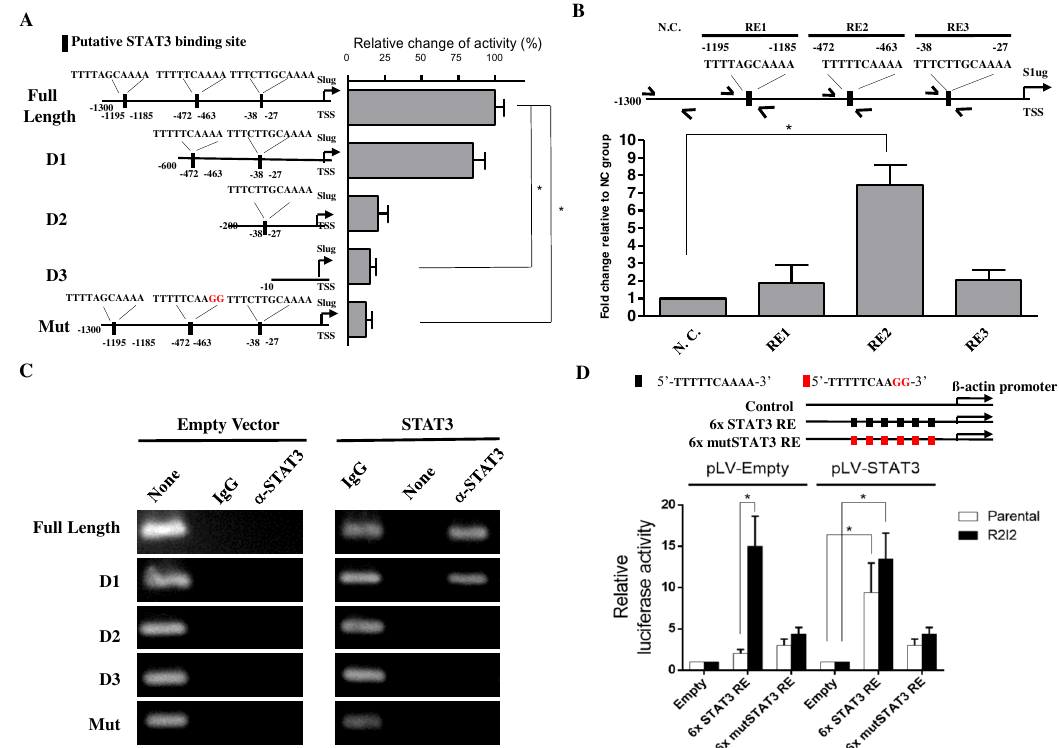
Figure 3. STAT3 directly regulated Slug transcription via binding to the STAT3 responsive sequence in the Slug promoter. ( A ) Left side: A graphical illustration of the full-length, deleted, and mutated Slug promoter-driven reporter plasmids. Right side: The quantification of luciferase activity driven by STAT3 from the different promoters in GBM-Par cells. ( B ) STAT3 at the indicated loci in the Slug promoter, including the nonspecific control (N.C.), RE1, RE2, and RE3 analyzed by Quantitative Chromatin Immunoprecipitation (Q-ChIP) assay in GBM-R2I2 cells. The amplicon N.C. was selected according to STAT3-upstream which has no STAT3 binding sites. ( C ) ChIP assay of STAT3 at the full-length or mutated Slug promoter regions. Specific STAT3-binding signal after ectopic STAT3 expression was compared with empty vector in GBM-Par cells. IgG antibody was used as a negative control. ( D ) Luciferase assay of examining the transcriptional effect induced by STAT3 overexpression in the Par or R2I2 GBM cells. The luciferase plasmid carrys a β -actin promoter, which contains empty, six repeated wild type or mutated STAT3 RE on the plasmid. Values expressed as fold enrichment relative to its empty group. All data represented as mean ± SD, n = 3, * p <